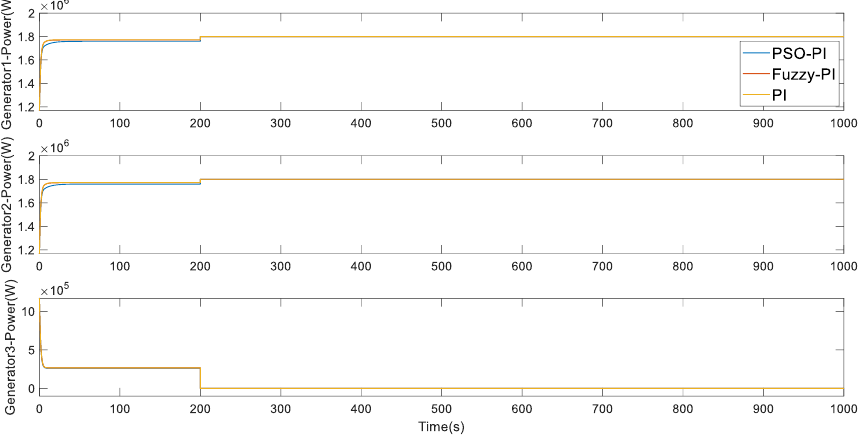
Figure 36. Output power of diesel generator when one generator fails.